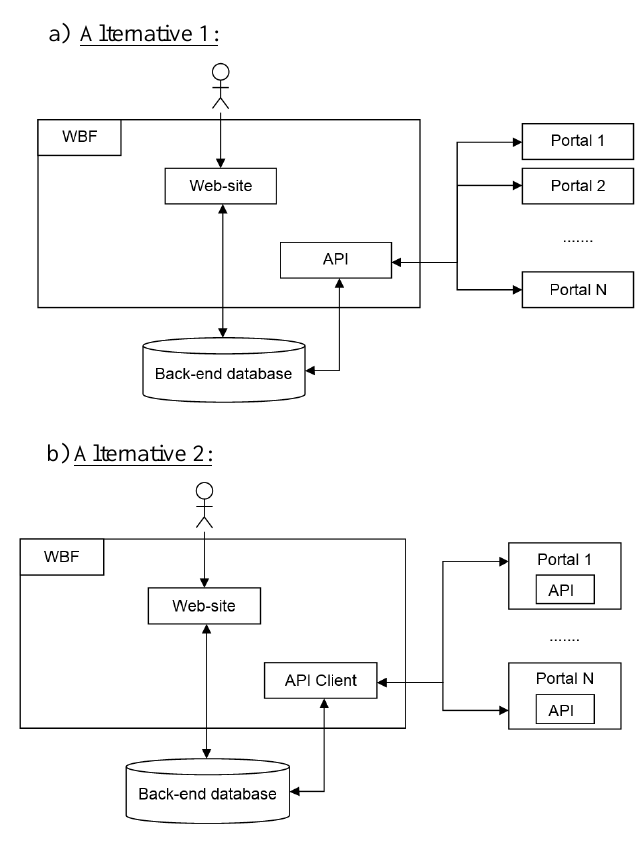
Fig. 2. Two alternatives of